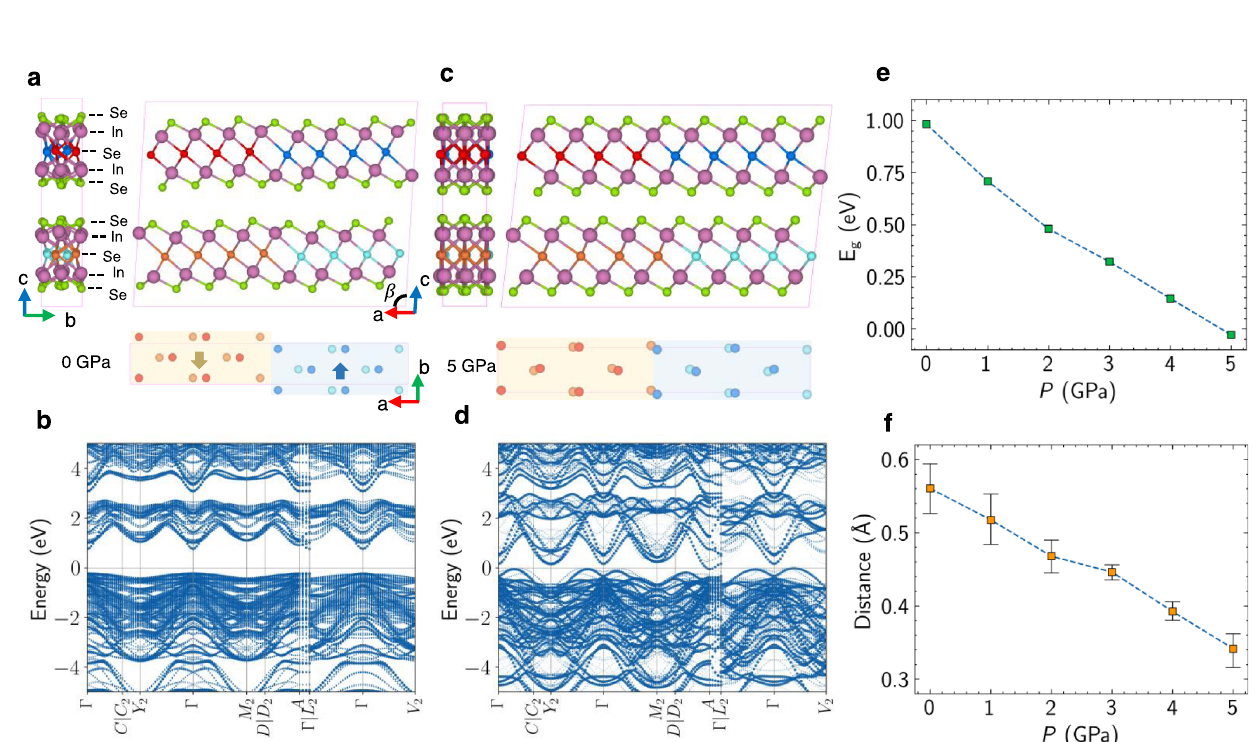
Fig. 3 | Pressure-dependent linear dichroism of β ′ -In 2 Se 3 . a – c Micrographs of linear dichroism take as pressure increases from 0GPa to 1.9GPa, showing dis- appearance of the observable domain contrast (narrow strips in a and b ). The